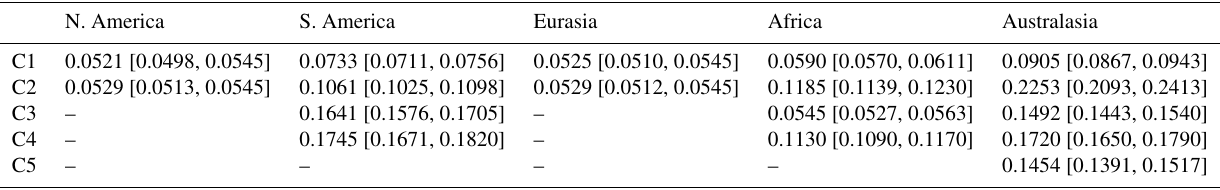
Table D1. Mean radiative forcing impact in milliwatts per square meter (mWm − 2 ) normalized by trajectories per cluster during January– March 2014. The rows denote the clusters in each region. N. America